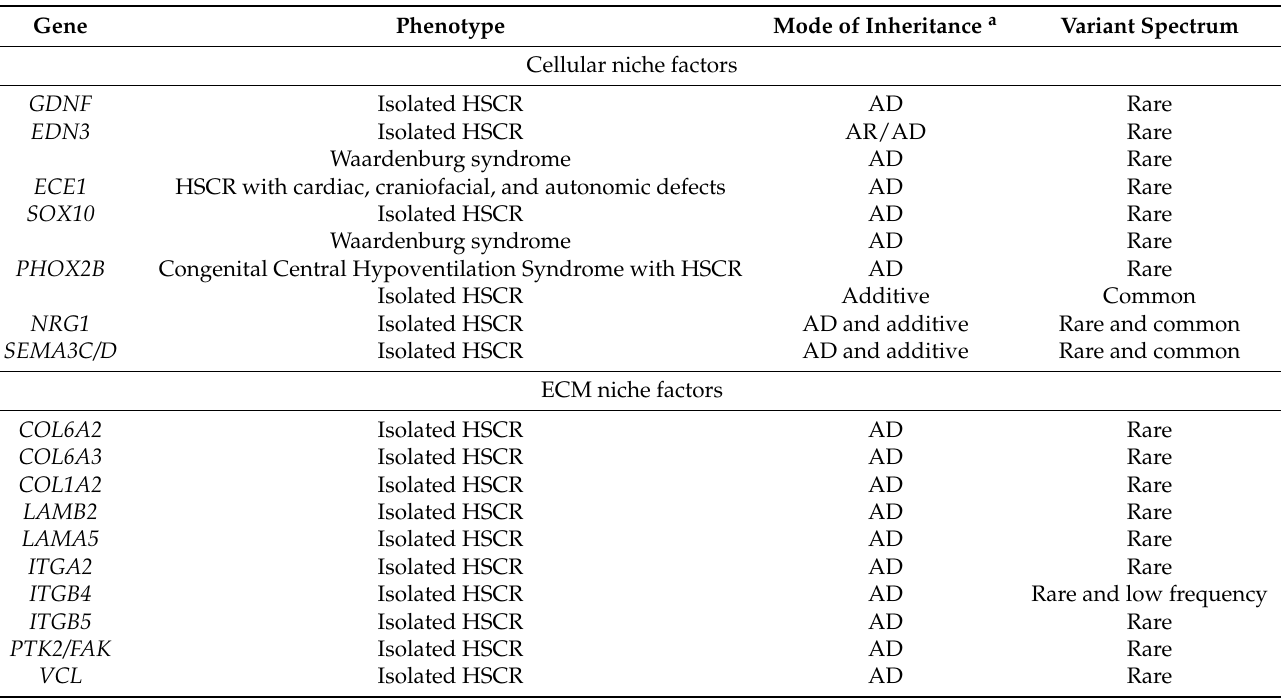
Table 1. Genes reported with common HSCR-associated variants or rare damaging protein-altering variants in HSCR